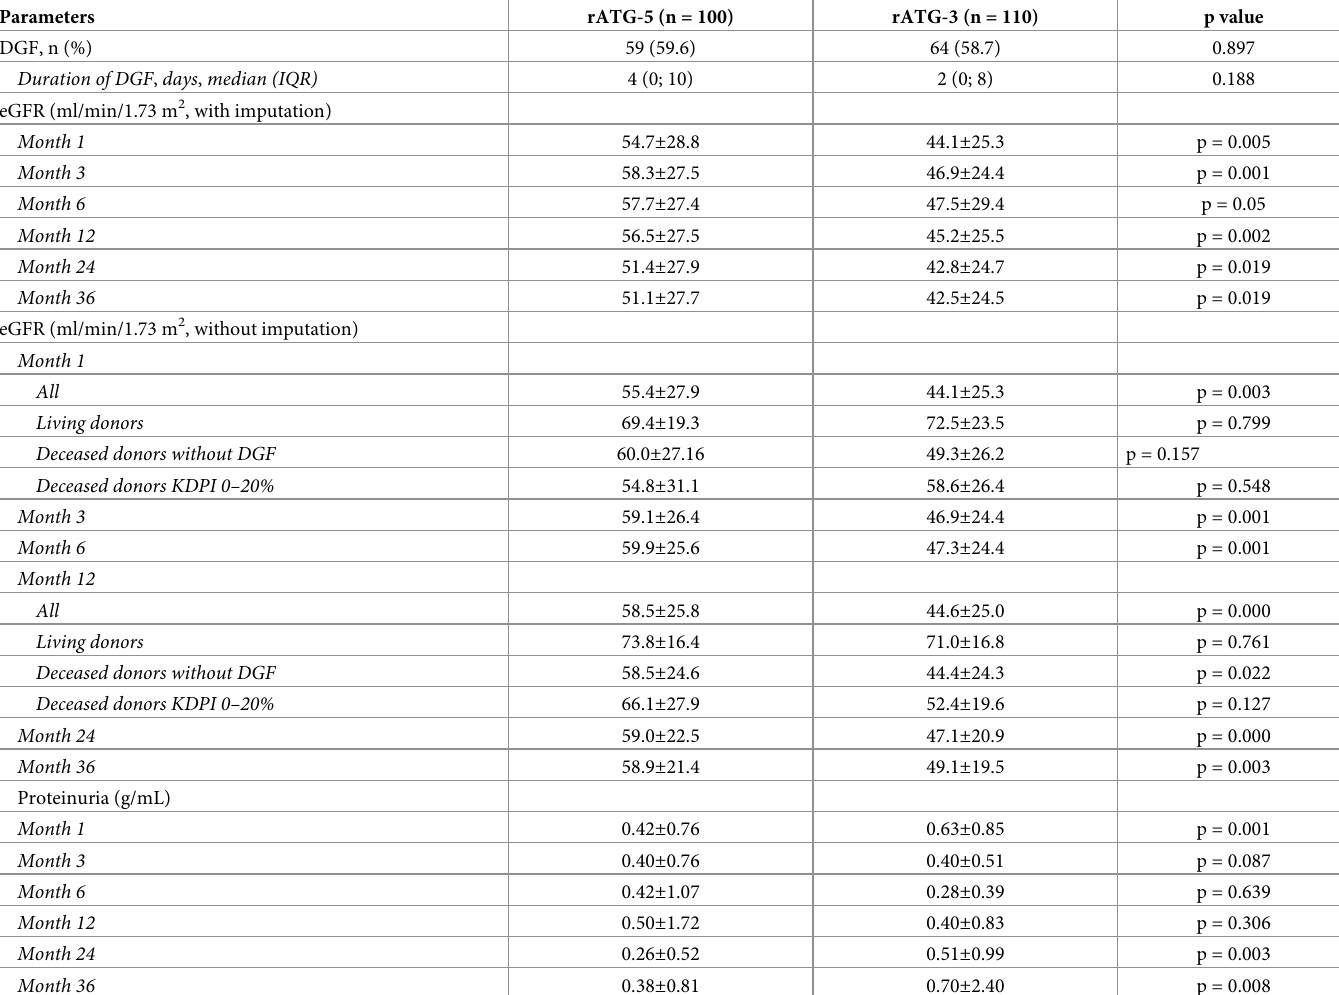
Table 5. Incidence and duration of DGF, trajectories of renal function and proteinuria.